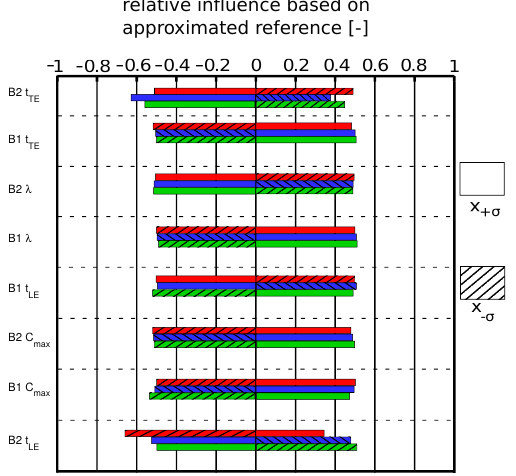
Figure 6. Sensitivities of ∆ p of blade 1 for all three operating points.